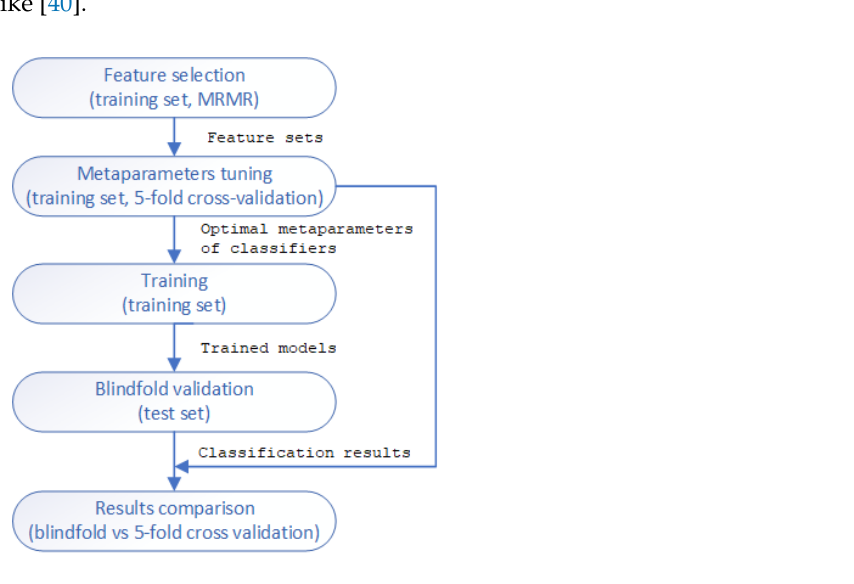
Figure 4. Diagram of training and validation methodology. MRMR — minimum redundancy maxi- mum relevance.